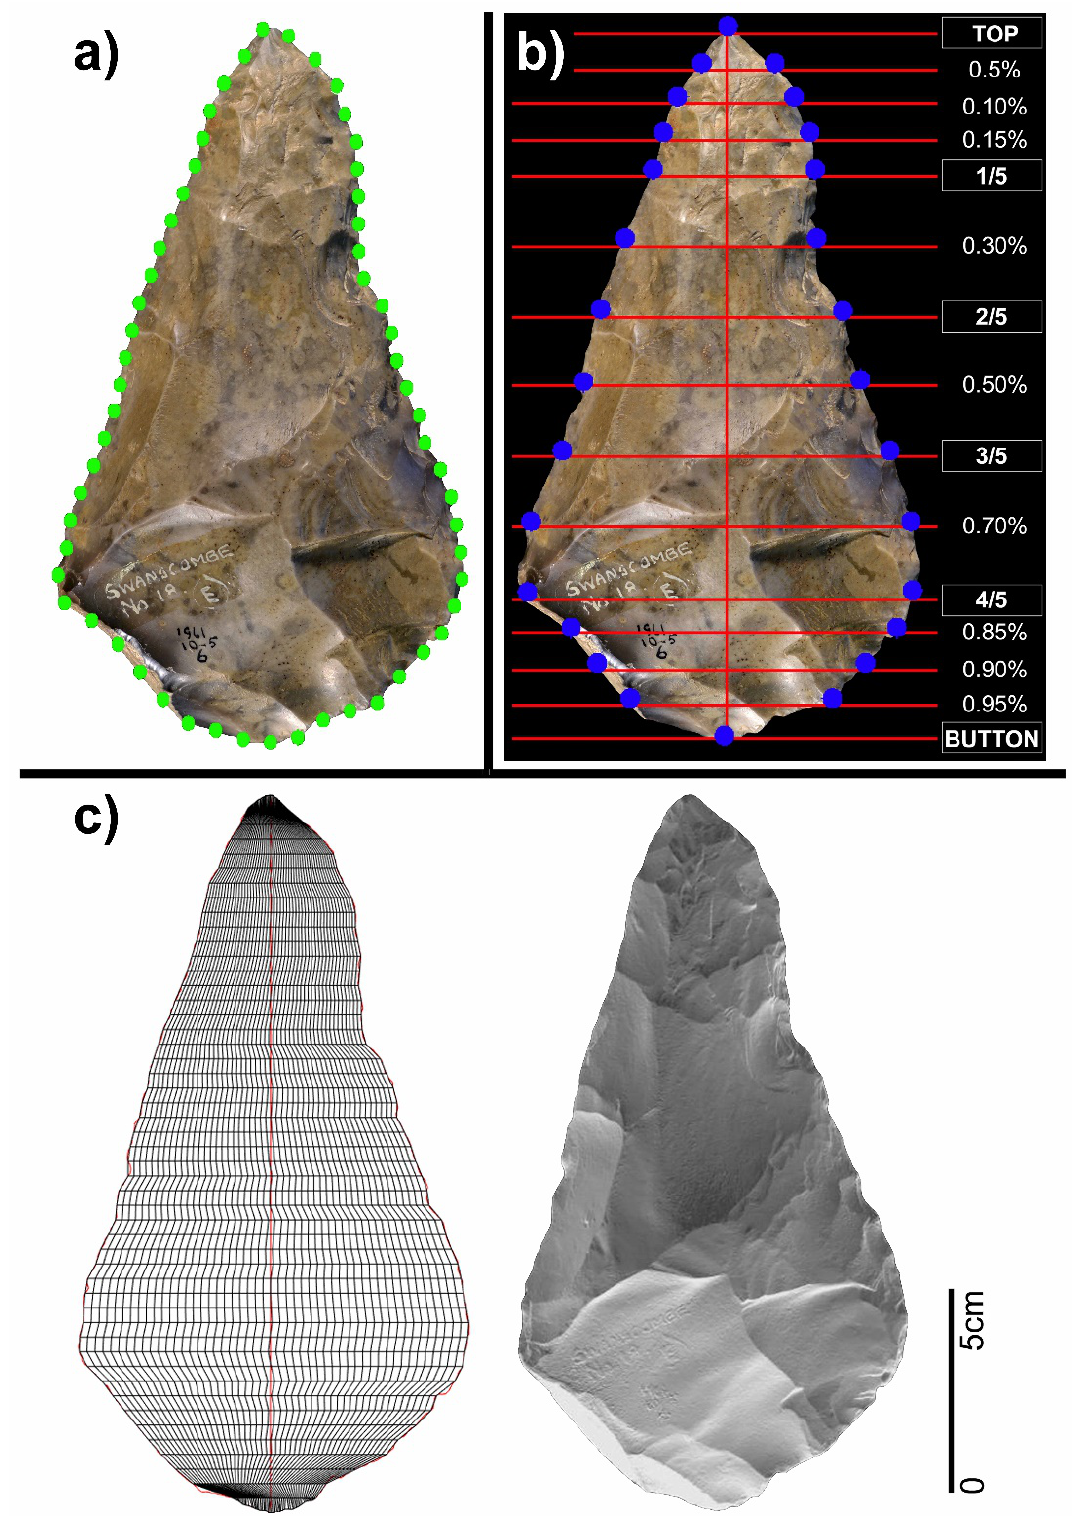
Figure 3. Three morphometrical approaches to the analysis of the morphological variability of handaxes using 2D images (a, b) and 3D models (c). a) 60 equally spaced points, b) 28 semi-landmarks, specially concentrated on tips and proximal parts, and c) 5000 points defining outlines and tool